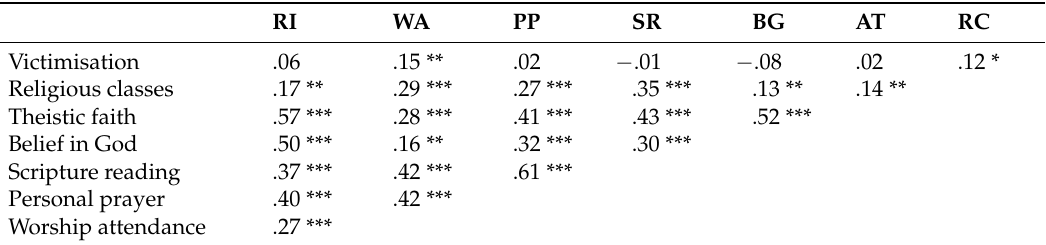
Table 4. Correlation matrix for religious variables and experience of victimisation.